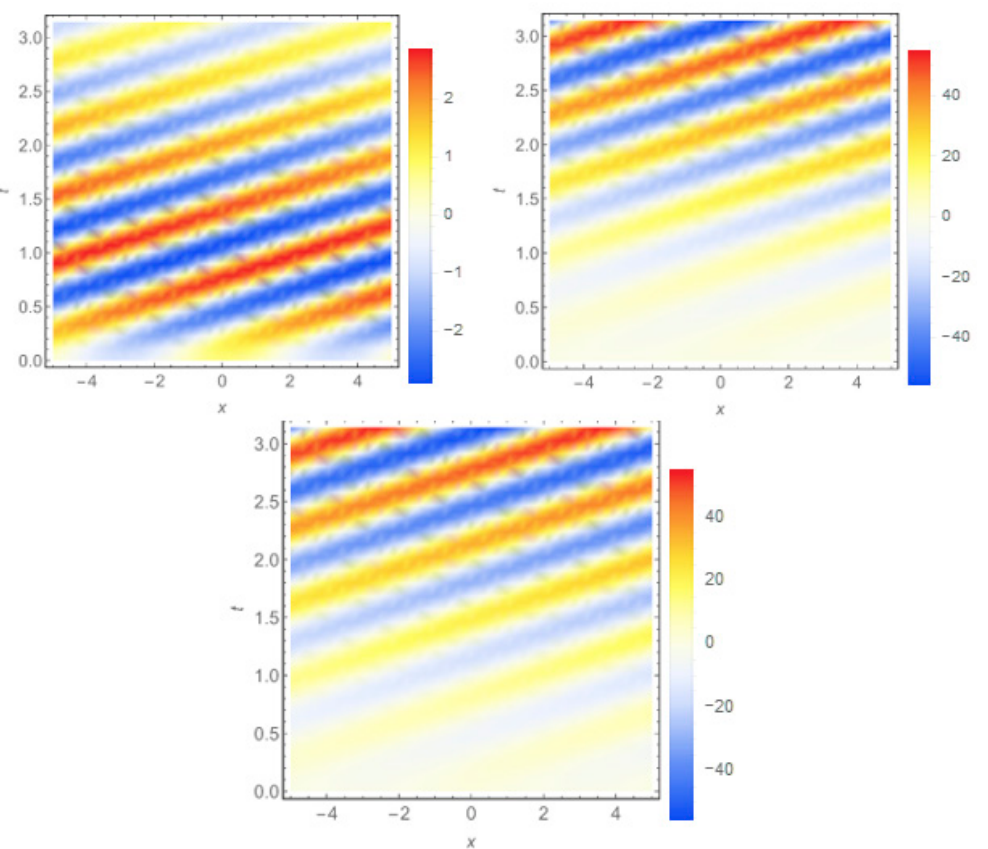
Figure 4. Evolution of quasi-temperature components in a thin film with Kn b = Kn d = 0.1 for v = +10: θ b ( x , t ) —top left plot, θ d ( x , t ) —top right plot and θ ( x , t ) = θ b ( x , t ) + θ d ( x , t ) —bottom plot. The Cauchy conditions for PDEs (9) and (10) system are θ b ( x ,0 ) = θ d ( x ,0 ) = e inx , ∂ t θ b ( x ,0 ) = ∂ t θ d ( x ,0 ) = 0.